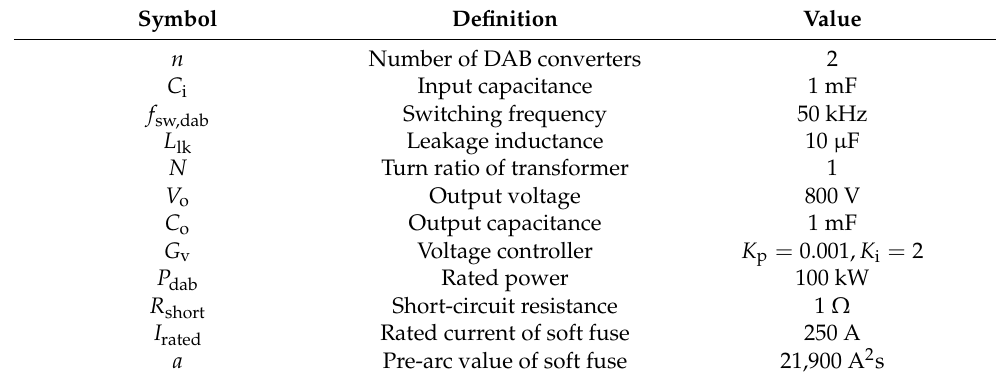
Table 2. Parameters of DAB converters.